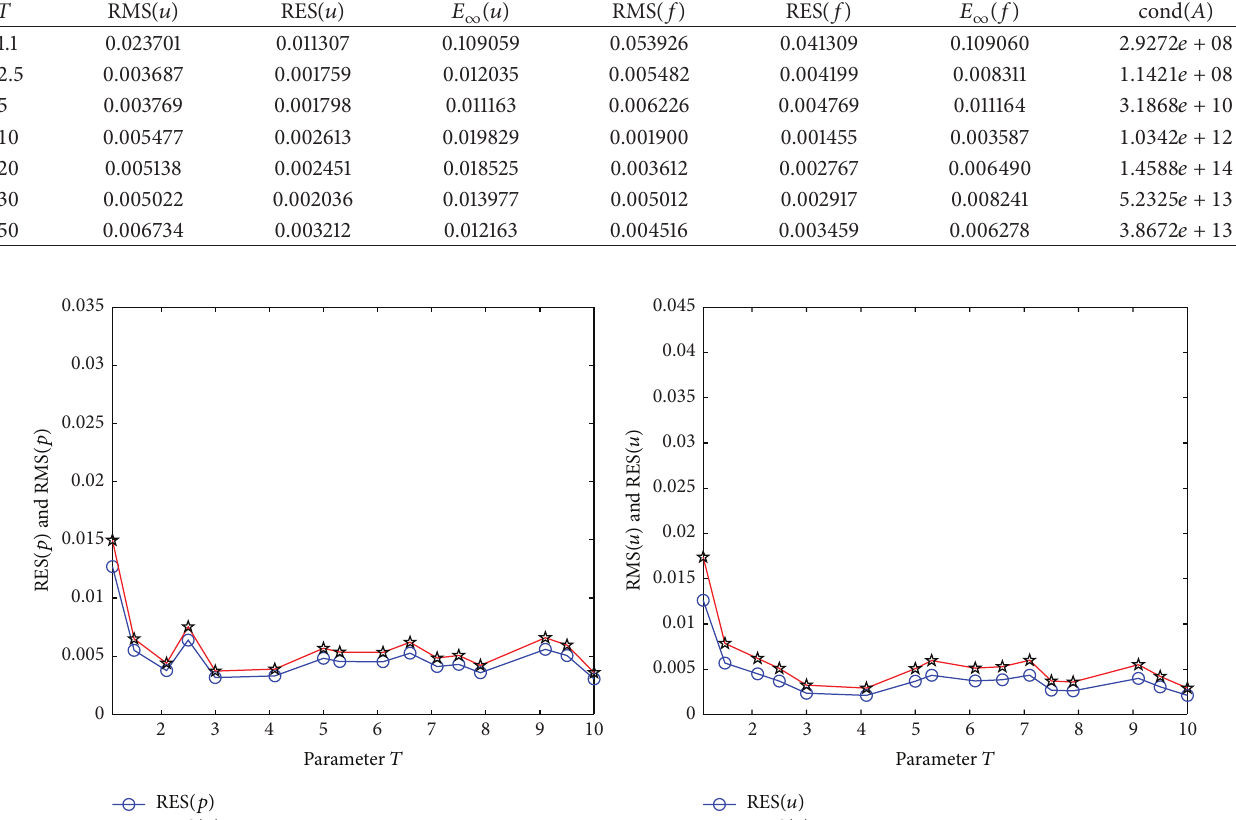
Table 4: The obtained values of RMS (𝑢), RES (𝑢), RMS (𝑓) , and RES (𝑓) using MFSRBF for various values of 𝑇 , 𝑥 0 = 0.5 , and 𝛿 = 0.01 by solving problem B .